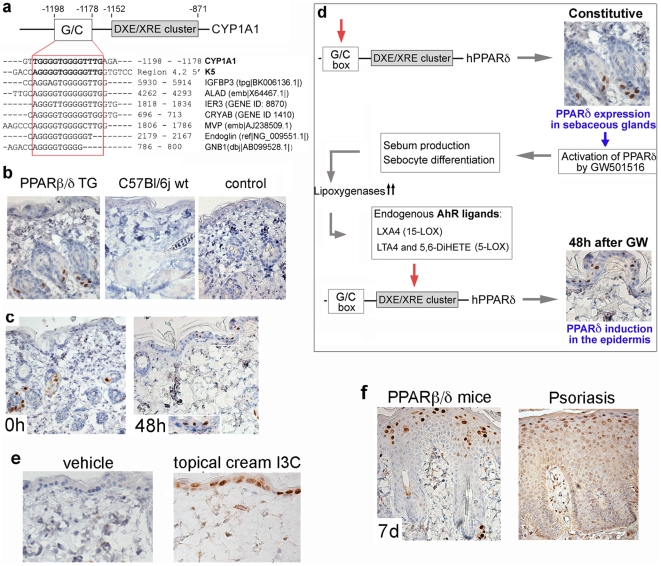
Inducible expression of PPARβ/δ in mouse epidermis.
A. Cis-regulatory elements in the rat CYP1A1 promoter used to drive inducible expression of human PPARβ/δ. Upper panel: Map of the sebaceous – specific G/C-box element and the AHR – responsive DXE/XRE cluster in the cyp1A1 promoter as well as the human human K5 promoter. Bottom panel: ClustalW alignment of promoters identified by a BLAST search using the 20 bp G/C element of the Cyp1A1 promoter. All of the genes shown were found in the top 10% percentile of all transcripts expressed in human sebaceous glands (GDS3215 at the NCBI GEO website www.ncbi.nlm.nih.gov/geo/). B. Immunohistochemistry using anti-PPARβ/δ of mice transgenic for human PPARβ/δ driven by the rat CYP1A promoter (PPARβ/δ TG), as well as wild type mice. Magnification 200× C. Immunohistochemistry of skin samples from PPARβ/δ transgenic mice taken before, or 48 h after after initiation of PPARβ/δ activation by oral administration of the synthetic ligand GW501516 in the chow; (inset in “48 h”: 400×); d. schematic illustrating the mechanism regulating constitutive expression of transgenic PPARβ/δ driven by the rat CYP1A1 promoter in sebaceous glands, as well as delayed PPARβ/δ expression in the epidermis after ligand-mediated activation of PPARβ/δ e. PPARβ/δ immunohistochemistry 48 h after topical cream application of indole-3-carbinole (I3C) to the skin of PPARβ/δ transgenic mice at 400× (right) magnification. f. Immunohistochemistry of PPARβ/δ in the skin of PPARβ/δ - transgenic mice after seven days of feeding of the PPARβ/δ ligand GW501516 in the chow (left) and in human psoriasis skin (right).